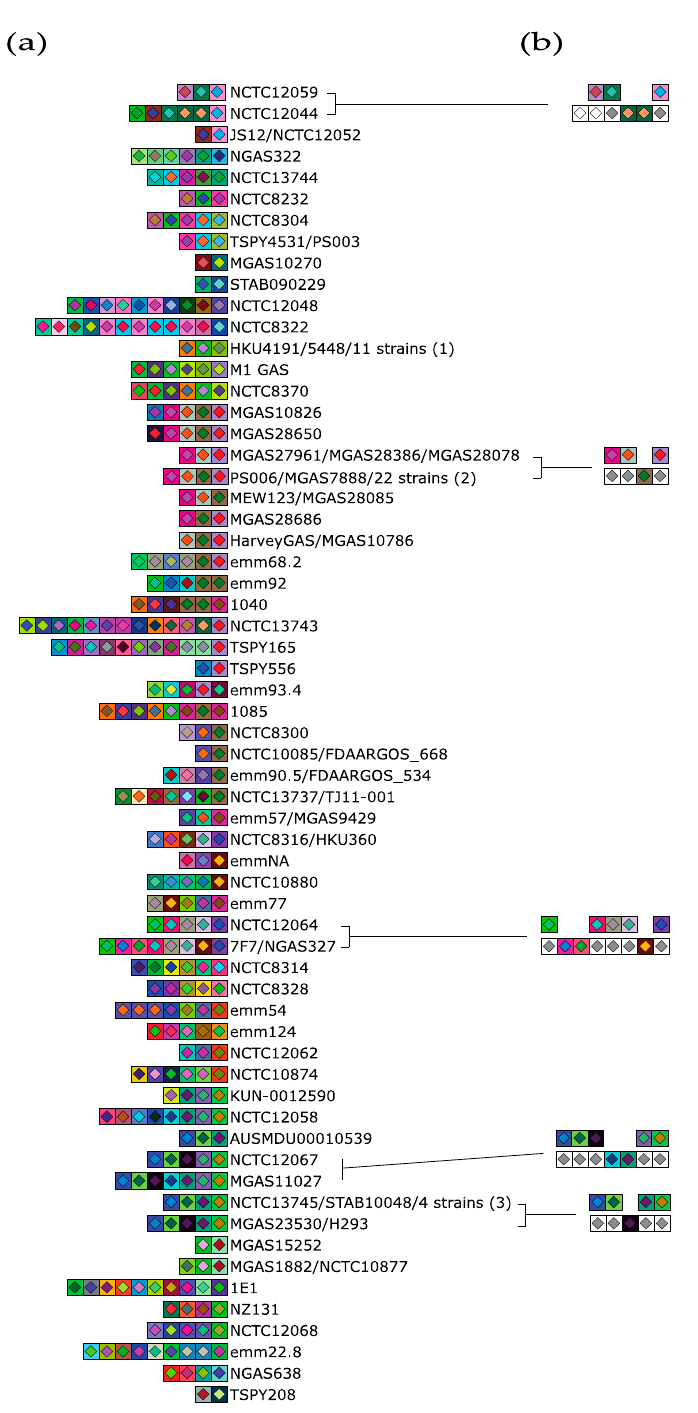
Figure 2. Spacer representation of CRISPR type II-A loci of S. pyogenes genomes using CRISPRStudio. ( a ) Type II-A CRISPR loci from public S. pyogenes genomes and containing at least two spacers. Some strains have identical CRISPR arrays and it includes Group 1: Strains S119, MGAS2221, emm1, FDAARGOS_149, HKU488, 5448, 10-85, MTB314, M1 476, MGAS5005, A20. Group 2: MGAS7914, MGAS8347, MGAS11052 MGAS11108, MGAS11115, MGAS28191 MGAS28271, MGAS28278, MGAS28330, MGAS28360, MGAS28533, MGAS28669, MGAS28746, MGAS29064, MGAS29284, MGAS29326, MGAS29409, M28PF1, STAB09014, STAB10015, MGAS6180, NIH35. Group 3: STAB09023, MGAS27061, JMUB1235, KUN-0014944. ( b ) Examples of possible ectopic acquisition or insertion/deletion events in S. pyogenes CRISPR arrays. The order of the spacers is the same as in panel a. White square harboring a light gray diamond represents similar spacer. White square harboring a white diamond represents unique spacer on the 5 ′ end of the array.